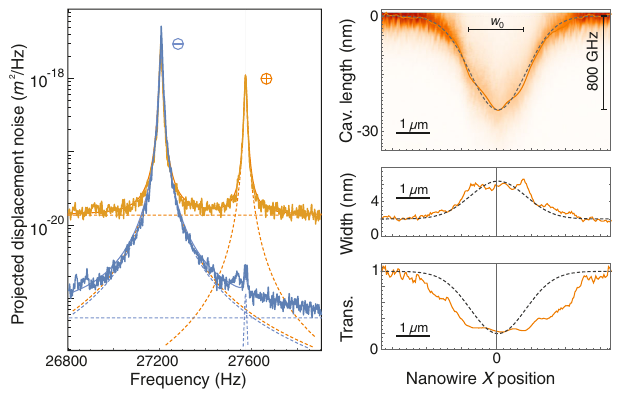
FIG. 8. Coupling strength with a 160-nm-diameter nanowire (NW2). Left: thermal noise at 300 K of a 160-nm-diameter nanowire, measured along two measurement channels [50]. It presents an effective mass of 2 × 10 − 15 kg, oscillates at 27200 = 2 π ¼ 10 Hz damping rate. In this and 27580 Hz, with a Γ m measurement, the lower eigenmode orientation is oriented perpendicular to the optical axis, to be ideally read by the ffiffiffiffiffiffi p differential channel ⊖ . It conveys a 30 aN = Hz force sensitivity, ¼ 7 . 8 nm (64 pm) at with thermal noise spreading over Δ x th 300 K (20 mK) and zero-point fluctuations spreading over δ x ¼ 0 . 4 pm. Right: cavity resonant length shifts measured zpf at 767 nm while scanning the nanowire transversally ( x axis) across the cavity mode, through an antinode (fitted optical waist of w 0 ¼ 1 . 6 μ m). The maximum parametric shifts amount to a cavity length change of − 24 . 7 nm (total length 12 μ m), corre- sponding to an equivalent þ 800 -GHz resonance frequency = 2 π ¼ increase. The corresponding maximum slopes are G x 0 . 6 GHz = nm and G = 2 π ¼ 6 . 5 GHz = nm, and they lead to a z ¼ ð 0 . 24 ; 2 . 6 Þ MHz, which single-photon coupling strength of g 0 represents a maximum ultrastrong coupling ratio g 0 = Ω of m approximately 100. The dynamical rms broadening of the cavity Δ x ≈ 2 π 50 GHz in frequency, or resonance is approximately G z th 1.6 nm in effective resonance width, which is slightly smaller than the 4-nm line broadening observed